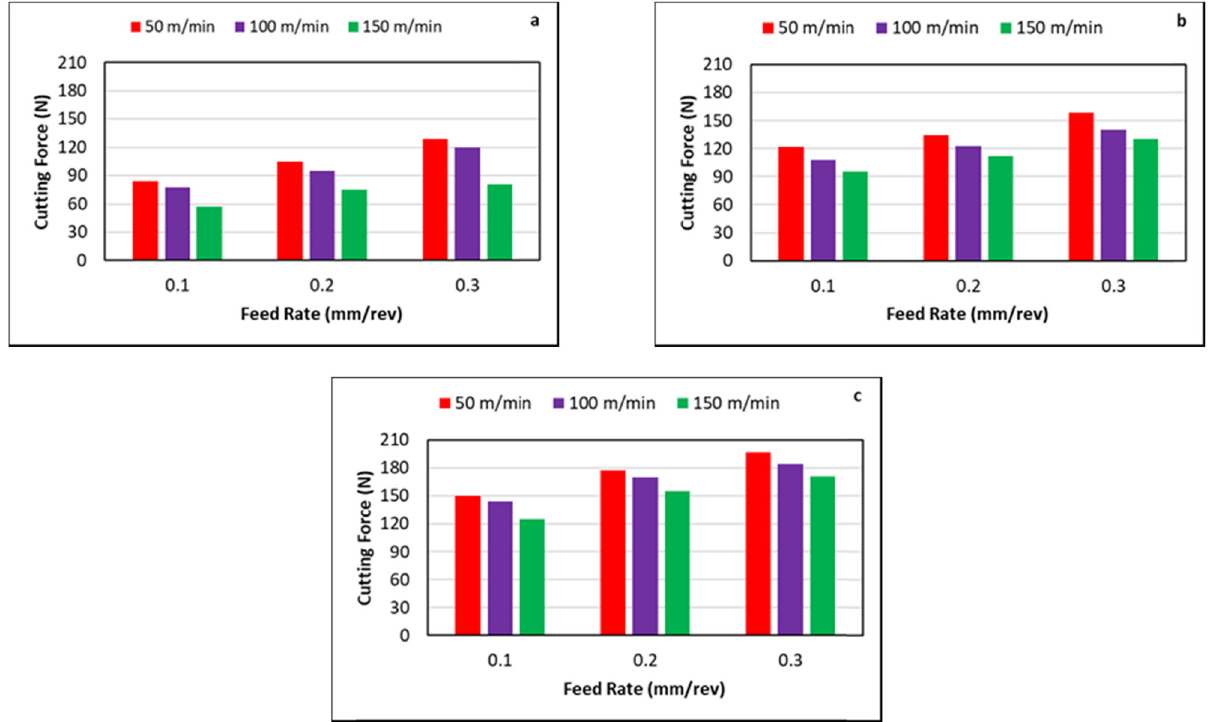
Figure 7: In fl uence of feed rate on cutting force at constant depth of cut 2 mm: ( a ) fi ber orientation 30°, ( b ) fi ber orientation 60°, and ( c ) fi ber orientation 90°.